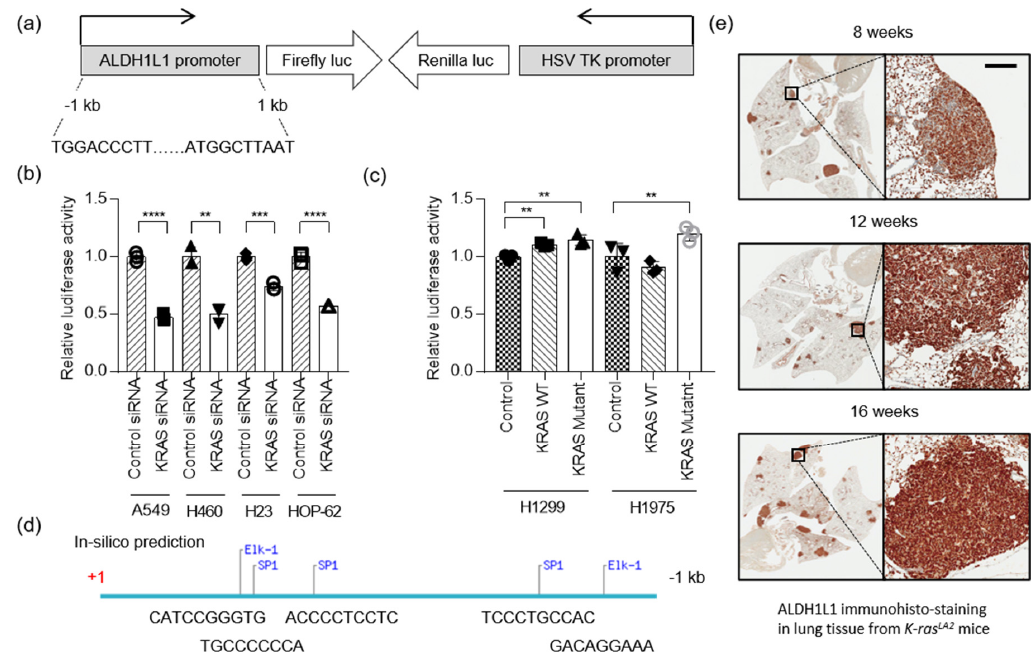
Figure 2. ALDH1L1 is a target of oncogenic KRAS. ( a ) Schematic representation of the reporter construct used in the cell-based transduction system. This lentiviral reporter construct expressed firefly luciferase under the control of the ALDH1L1 promoter and Renilla luciferase under the control of the HSV TK promoter. ( b ) KRAS -mutant NSCLC cells stably expressing the reporter system described in ( a ) were treated with control or KRAS siRNA. Firefly and Renilla luciferase activities were normalized against the corresponding levels in the sample transfected with control siRNA. Bars show relative luciferase activity ( n = 3). ( c ) KRAS WT NSCLC cells stably expressing the reporter system described in ( a ) were transfected with control (empty vector), KRAS WT, or KRAS mutant (G12D). Firefly and Renilla luciferase activities were normalized against the corresponding levels in the sample transfected with empty vector. Bars indicate relative luciferase activity ( n = 3). ( d ) In silico prediction of binding sites for transcription factors downstream of KRAS: SP1, transcription factor Sp1; Elk-1, ETS Like-1 transcription factor. ( e) Immunohistochemical staining of ALDH1L1 in lungs isolated from Kras LA2 mice at 8, 12, and 16 weeks of age. The scale bar represents 200 mm (** p < 0.01, *** p < 0.001 and **** p <